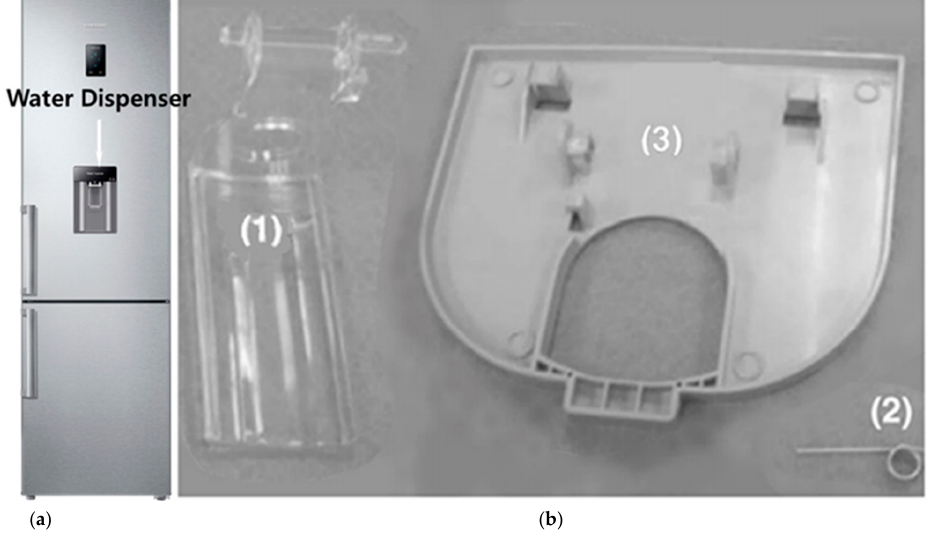
Figure 7. New water dispenser assembly in a refrigerator. ( a ) A domestic refrigerator and ( b ) mechanical components of the water dispenser. (1) Dispenser lever cost-downed from stainless steel, (2) spring, and (3) cover.